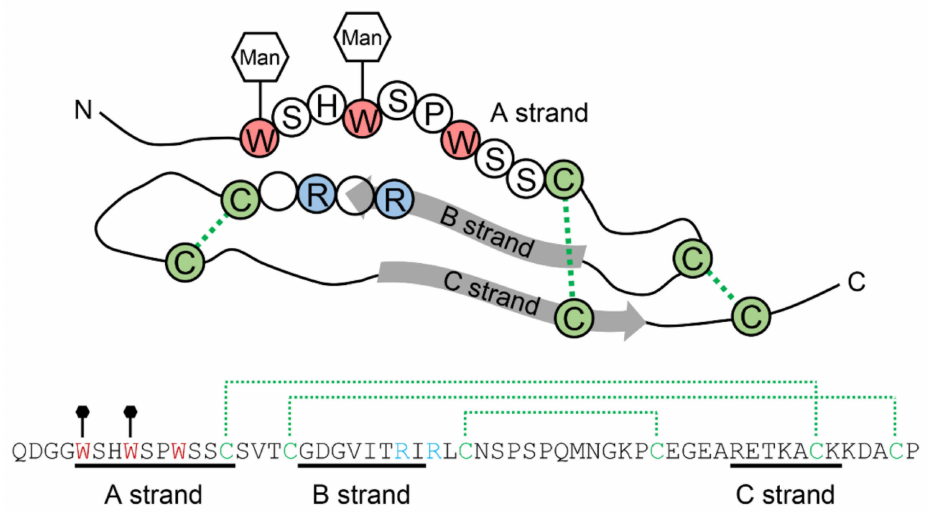
Figure 2. Schematic structure and sequence of thrombospondin type I repeat 2 (TSR2) in human thrombospondin-1 (TSP-1). TSR2 consists of an antiparallel three-stranded domain, in which the A strand assumes a unique rippled conformation and B and C strands form β structures [9]. The A strand has a conserved sequence motif of W-x-x-W-x-x-W-x-x-C, and the first two Trp residues were confirmed to be C -mannosylated [27]. The disulfide bonds are marked by green dashed lines connecting paired Cys residues. The TSR2 domain is stabilized by the “Trp-Arg ladder” motif, in which three Trp residues from the A strand are stacked with Arg residues from the B strand. Man,